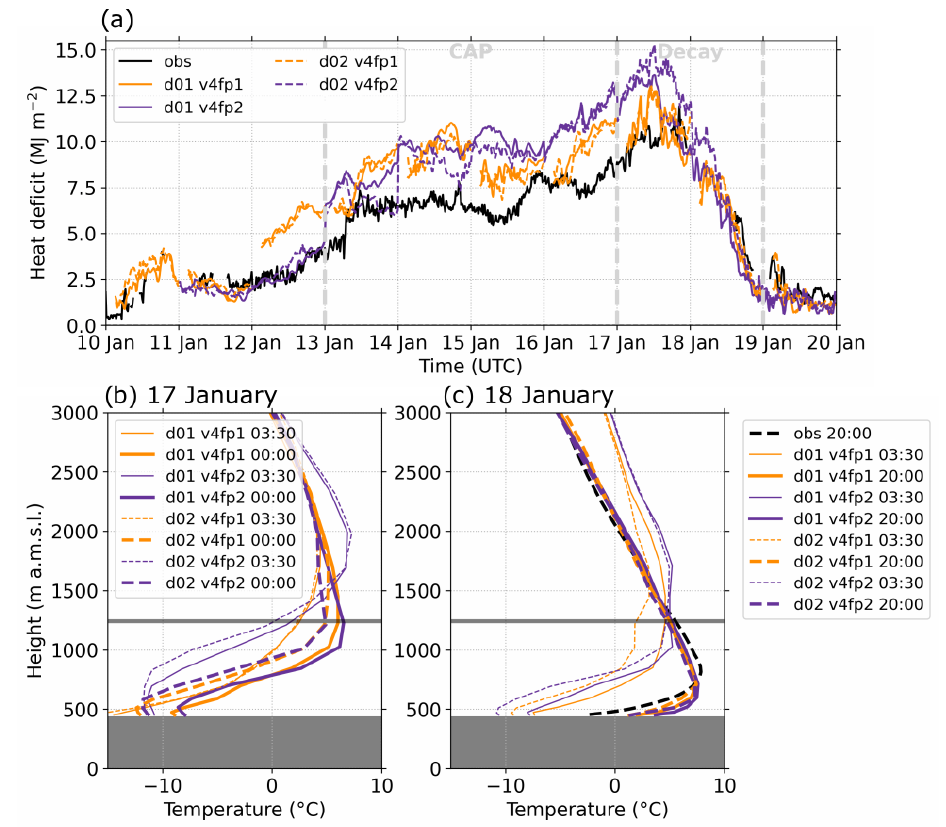
Figure 10. (a) Time series of the heat deficit (Eq. 1) from observations and model runs v4fp1 and v4fp2 at Wasco. Profiles of simulated temperature at Wasco during the Decay period on (b) 17 January and (c) on 18 January at the beginning (thin lines) and end (thick lines) of the respective day. In panel (c) , the observed temperature profile at 20:00UTC is added. The horizontal gray line indicates the mean ridge height, and dark gray shading indicates the station